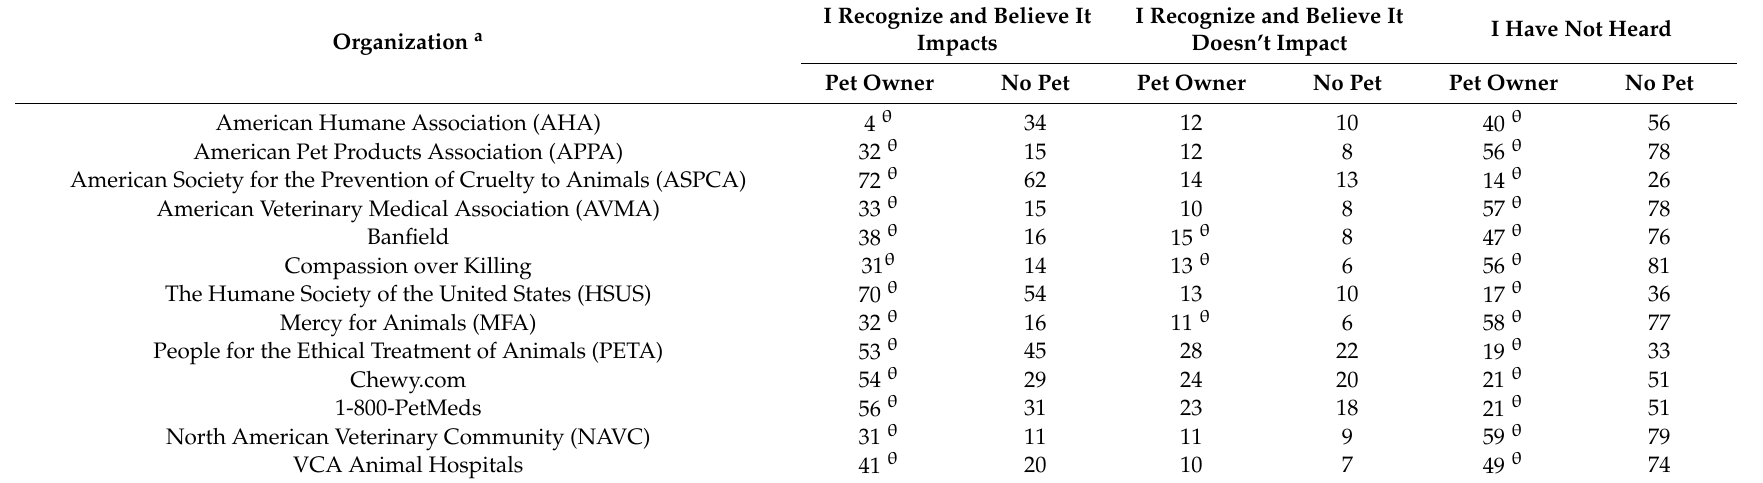
Table 6. Recognition and perceived impact of organizations, percent (%) of pet owners (n = 664) and non-pet owners (n = 336). Organization